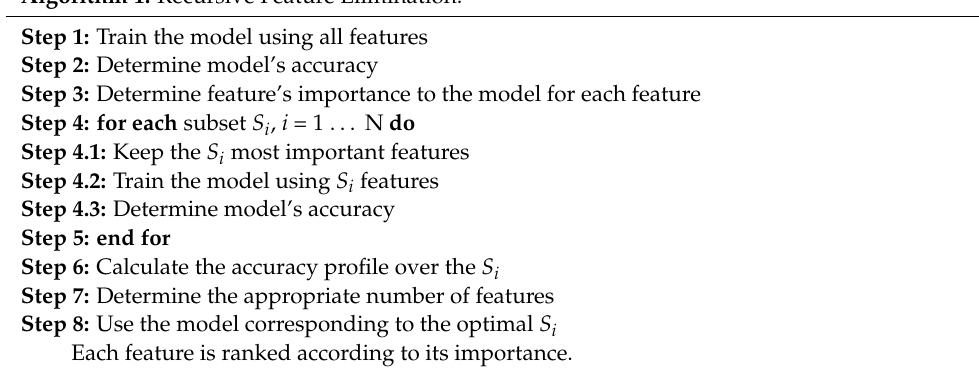
Algorithm 1: Recursive Feature